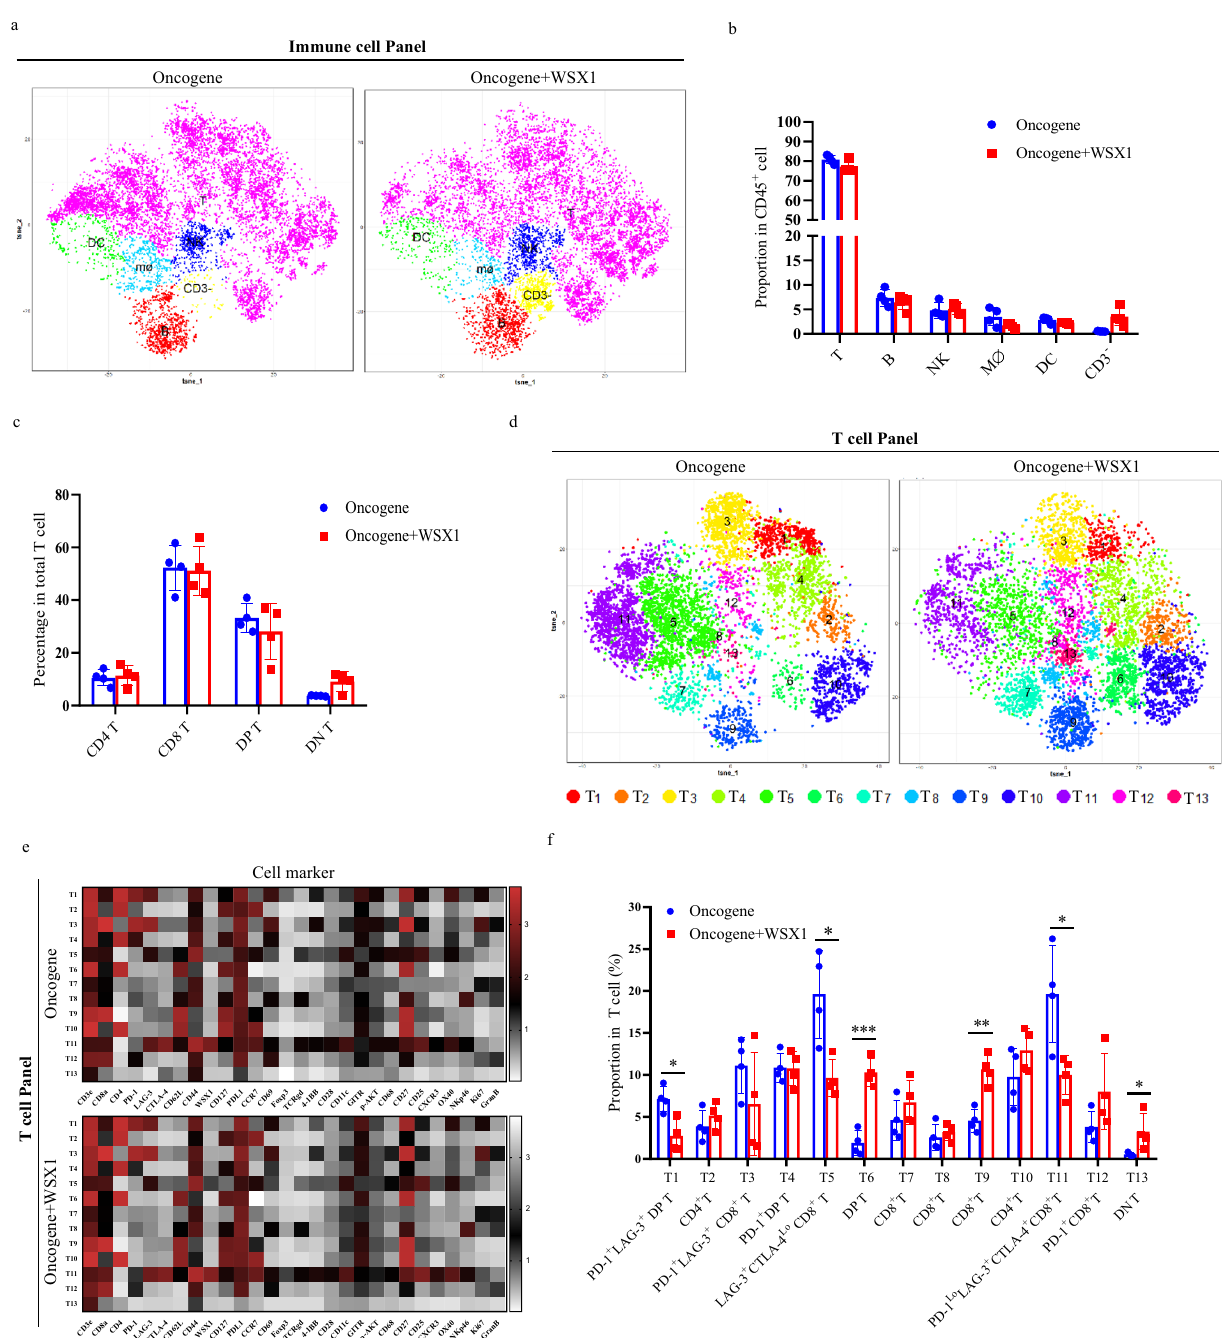
Fig. 3 WSX1 inhibits HCC development by relieving T-cell exhaustion. a t-distributed stochastic neighbor embedding (t-SNE) map derived from time-of- fl ight mass cytometry (CyTOF) analysis of intrahepatic immune cells obtained from the HCC mouse model in Fig. 2a ( n = 4). Cells are colored by clusters identi fi ed by Rphenograph. Clusters were grouped by expression pro fi le and manually assigned to 6 main cell subsets: T cells, B cells, NK cells, M ϕ , DCs, and other CD3 − cells. b The percentage of T, B, NK, M ϕ , DC, and other CD3 − cells among all intrahepatic immune cells ( n = 4). c The proportion of CD4 + , CD8 + , CD4 + CD8 + DP, and CD4 − CD8 − DN T-cell subsets among total intrahepatic T cells ( n = 4). d t-SNE map of intrahepatic T cells derived from CyTOF analysis. Rphenograph identi fi ed 13 T-cell subsets based on expression pro fi les of 28 markers. e Heatmap showing expression of 28 T-cell panel markers in 13 T-cell clusters. f Differences in the proportion of 2 CD4 + (T2 and T10), 7 CD8 + (T3, T5, T7, T8, T9, T11, T12), 3 DP (T1, T4, T6), and 1 DN (T13) T-cell clusters among total intrahepatic T cells ( n = 4). WSX1 reduced the proportion of T1 ( P = 0.0114), T5 ( P = 0.0126) and T11 ( P = 0.0216), while increased the proportion of T6 ( P = 0.0003), T9 ( P = 0.0016) and T13 subsets ( P = 0.0453). All data are representative of 2 independent experiments. Quantitative data are presented as mean ± SD and analyzed by two-sided Student t test. * P < 0.05, ** P < 0.01, *** P < 0.001. NK cells natural killer cells, M ϕ macrophages, DCs dendritic cells, DP double positive, DN double negative. Source data are provided as a Source Data fi le.